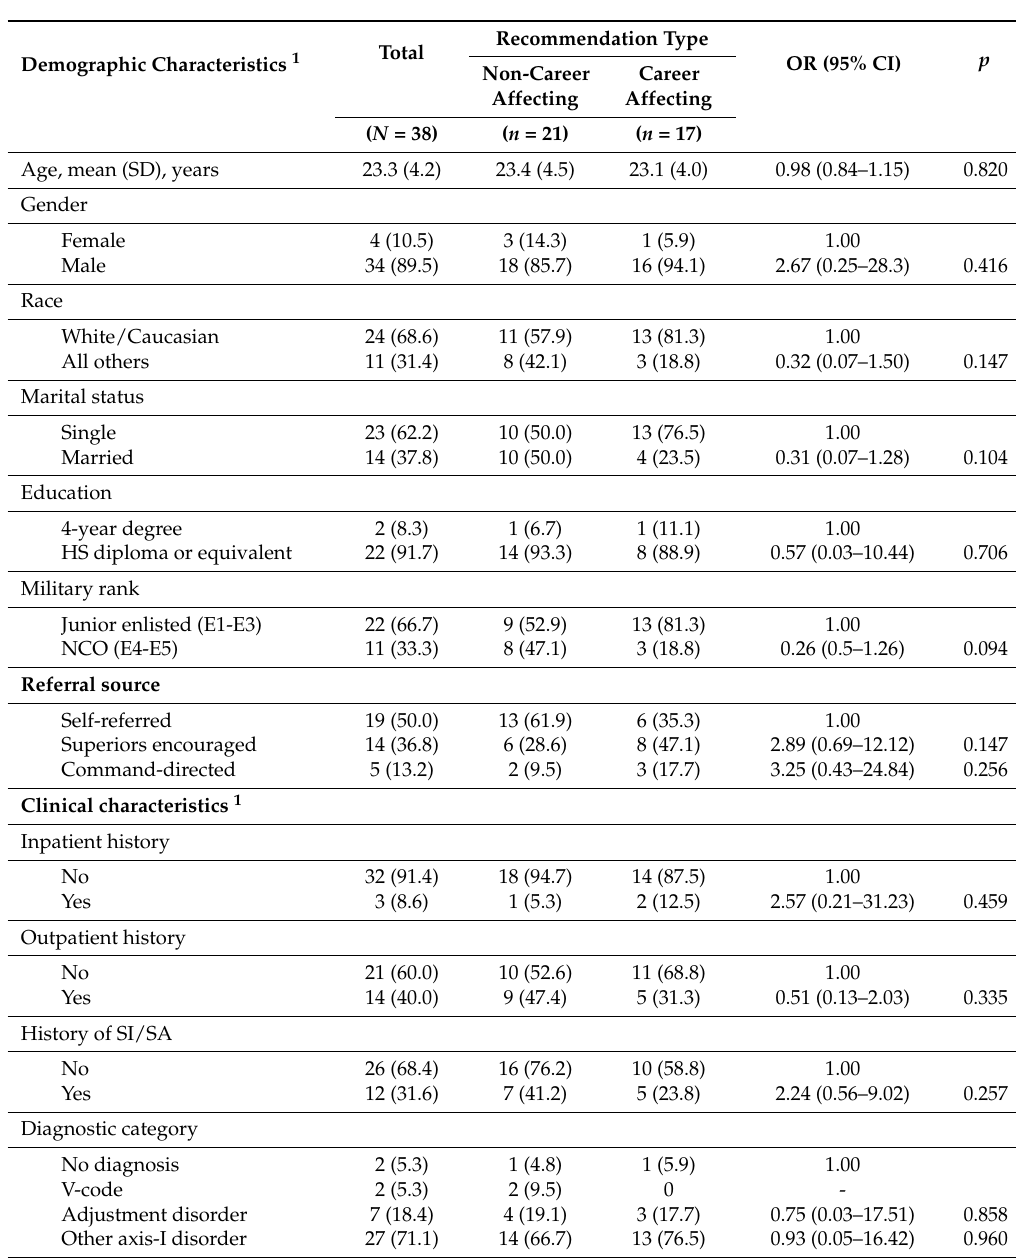
Table 2. Phase 1: Results of univariate logistic regression predicting career-affecting recommendation following outpatient behavioral health treatment ( N = 38)